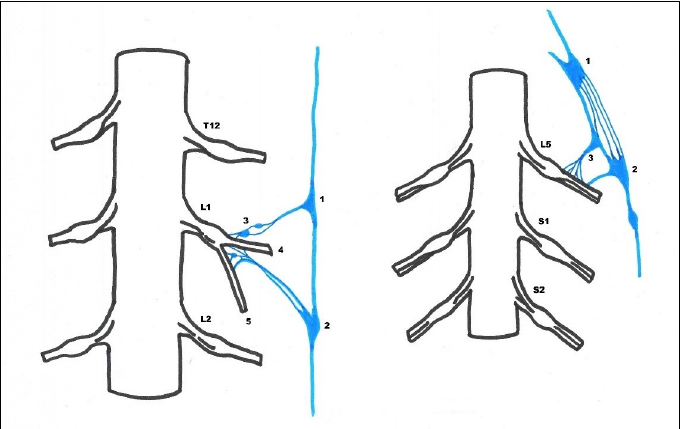
Figure 2. ( Left ): Between the penultimate and last ganglia of the lumbar part of the sympathetic trunk, multiple interganglionic connections are seen. The first (1) and the second (2) sympathetic trunk ganglion is connected by multiple rami communicantes with the L1 nerve, with additional small ganglia (3) near the intervertebral ganglia along the thin communicating branches. In the area of the intervertebral ganglia, the sympathetic branches are associated with the dorsal branch of the spinal nerve (r. dorsalis nervi spinalis) (5), as well as with its ventral branch (r. ventralis) (4). In some cases, an increase in the number of ganglia in the sympathetic trunk is combined with multiple interganglionic branches (rr. interganglionares), along which other small ganglia occur. ( Right ): In the following picture, multiple interganglial connections are visible between the last one (1) and last two (2) ganglia of the lumbar part of the sympathetic trunk. On one fascicle, there is a relatively large ganglion (3), which, like the last lumbar, is connected by rami communicantes with the spinal nerve